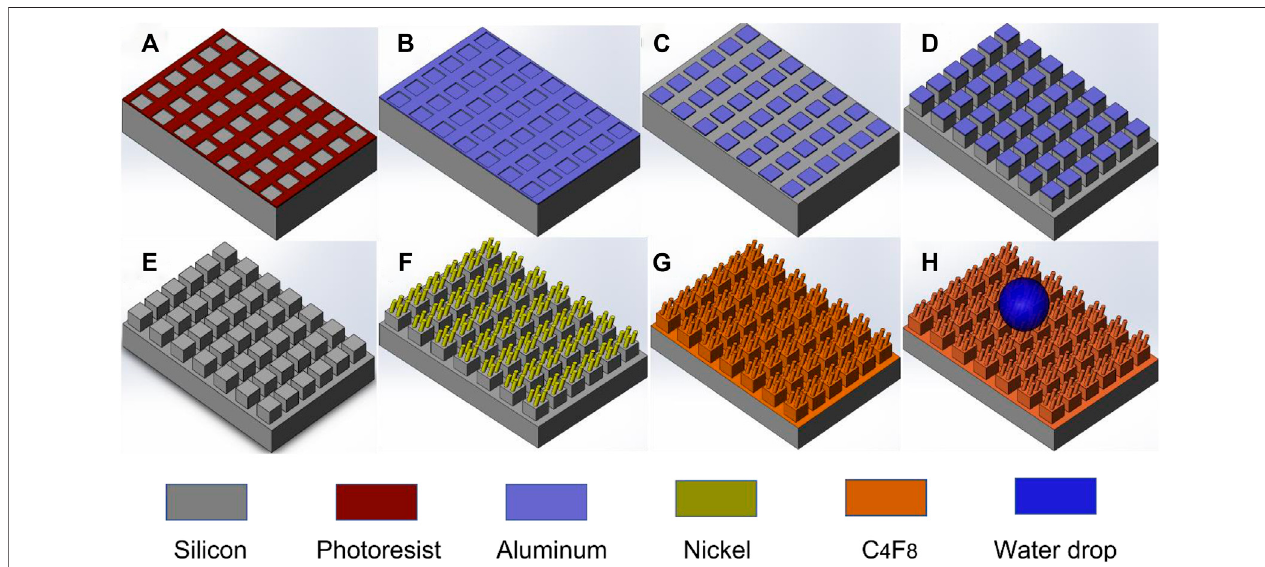
FIGURE 1 | Schematic illustration of the major fabrication processes of micro/nano hierarchical structure. (A) UV photolithography; (B) Aluminum deposition; (C) Aluminum lift-off process; (D) Deep reactive ion etch; (E) Removal of aluminum; (F) GLAD nickel nanowires; (G) C 4 F 8 deposition; (H) A water drop on the surface.